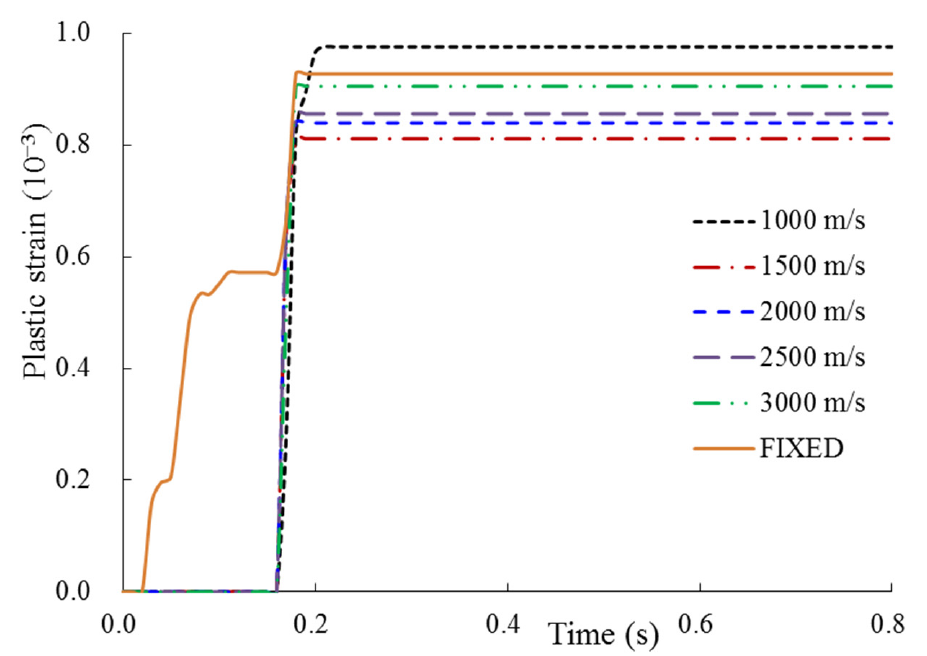
Figure 10. Max plastic strain time-histories of concrete.